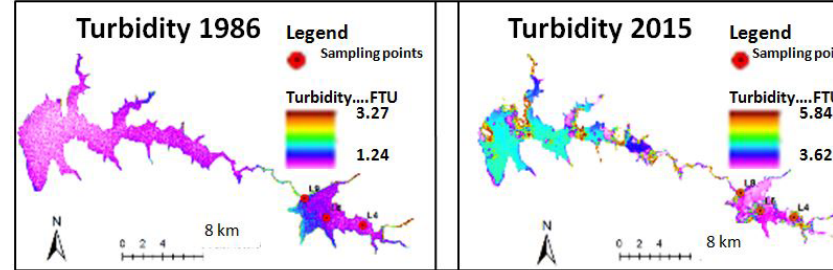
Figure 3. Spatial variations of Turbidity 1986 and 2015.